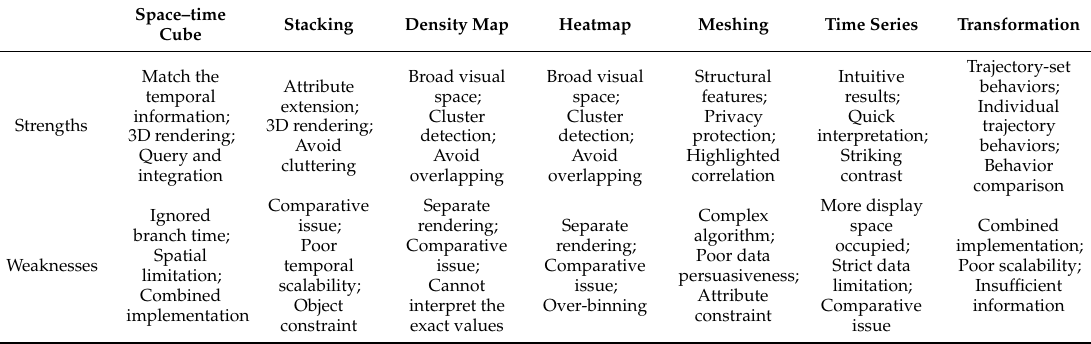
Table 2. Overview comparing strengths and weaknesses of low-dimensional visualization